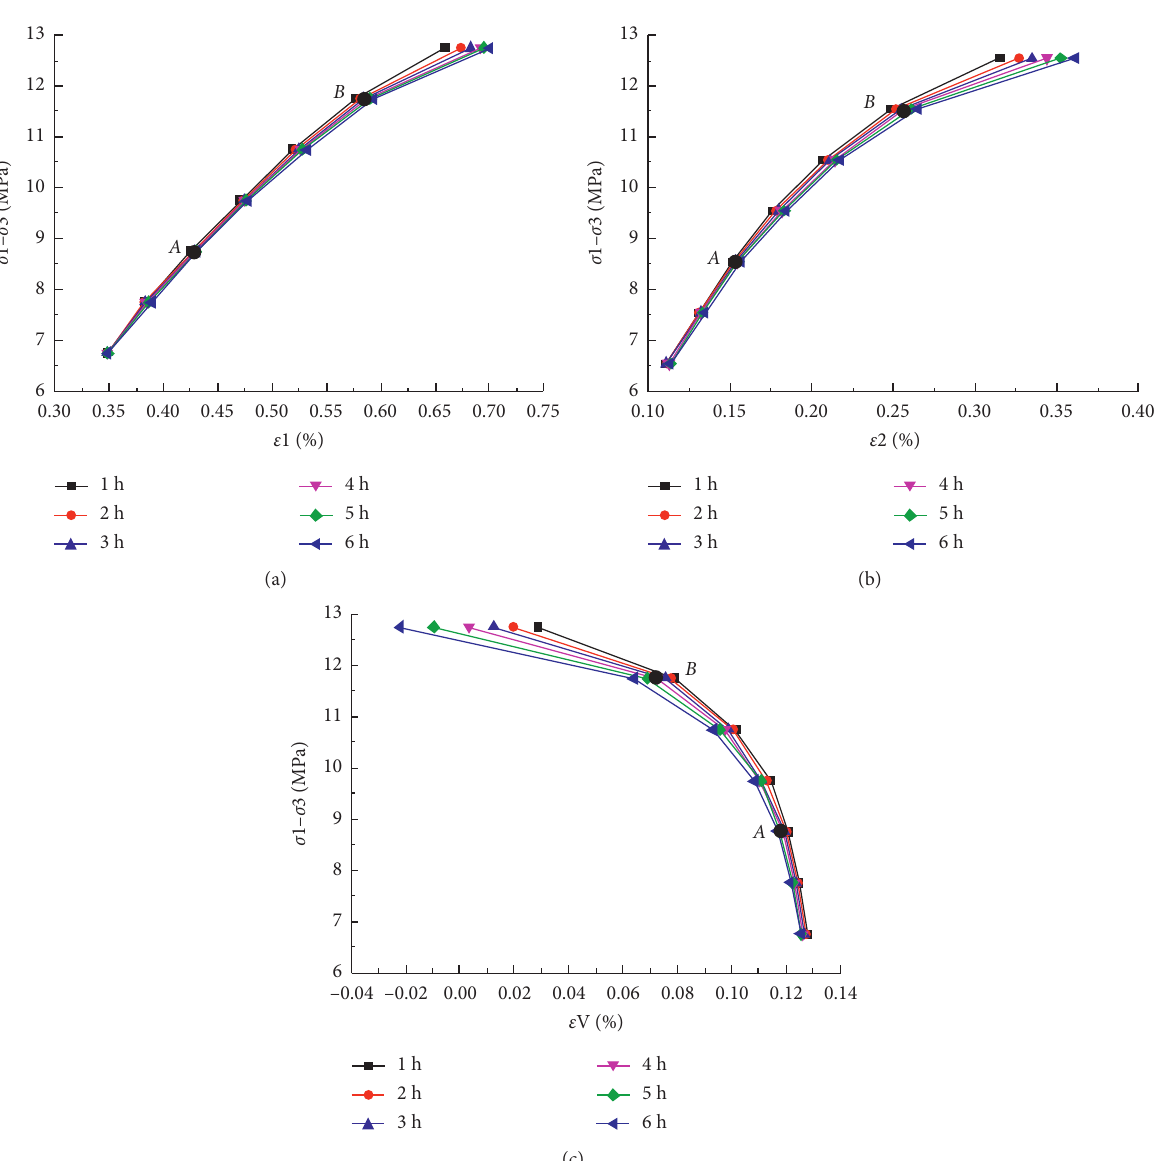
Figure 2: Stress-strain isochronous curve cluster: (a) axial strain; (b) lateral strain; (c) volume